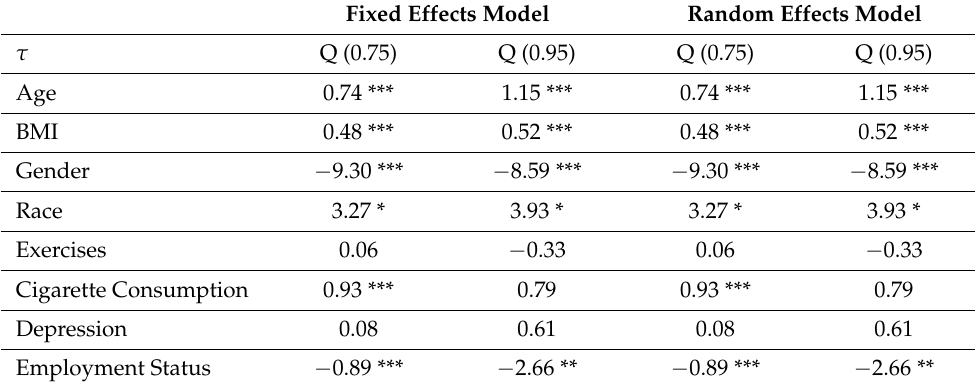
Table 5. Panel Quantile Regression Estimates for SBP’s Risk Factors.